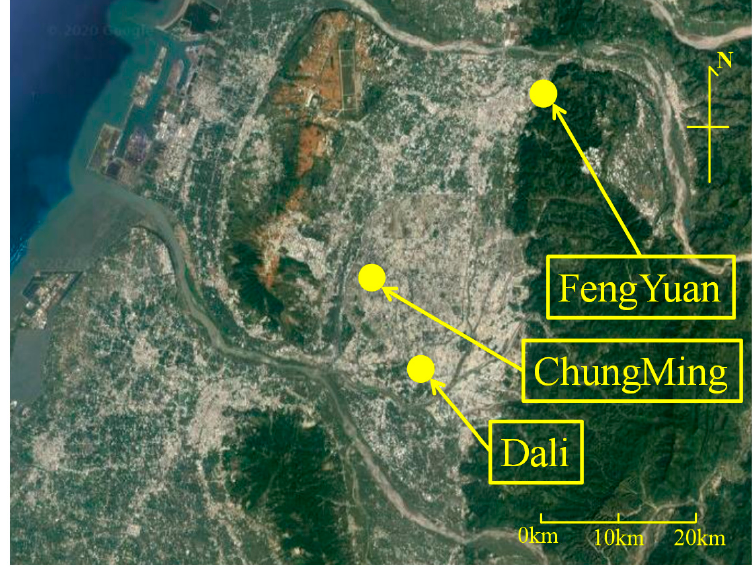
Figure 4. Locations of three particulate matter 2.5 (PM2.5) observation stations.